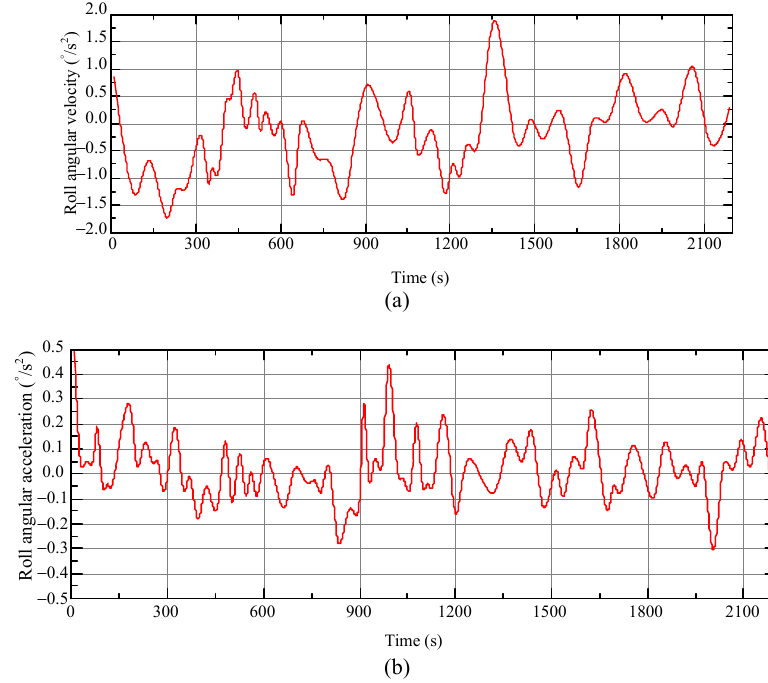
Fig. 6 Roll angular velocity (a) and the angular acceleration